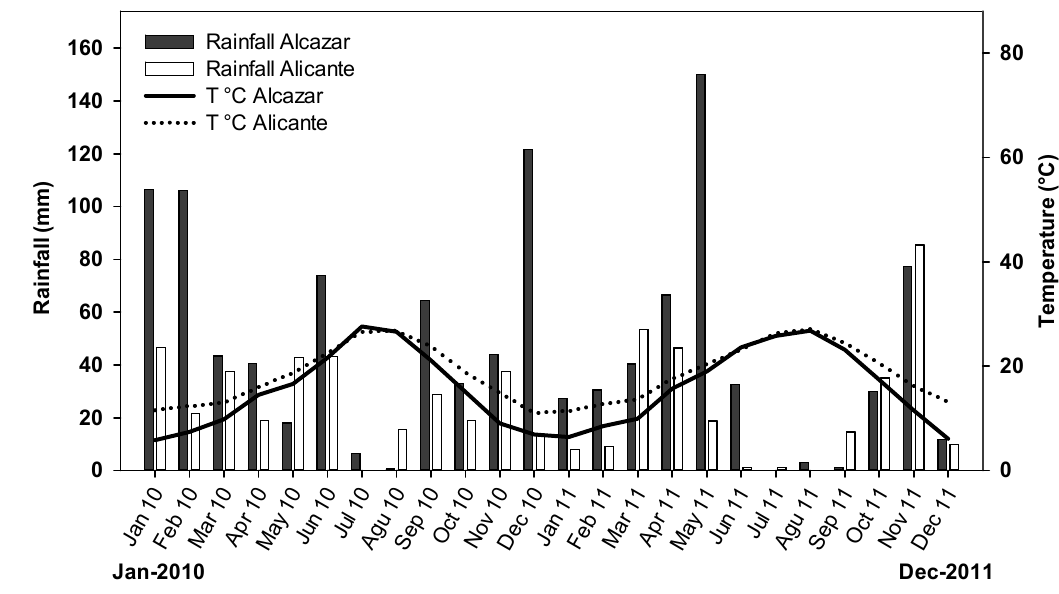
Figure 1. Climatic conditions in the two sites during study period. Rainfall (mm) and mean monthly temperatures ( ◦ C). Data from National Agency of Meteorology, Agriculture and Environment Department, Spanish Government.